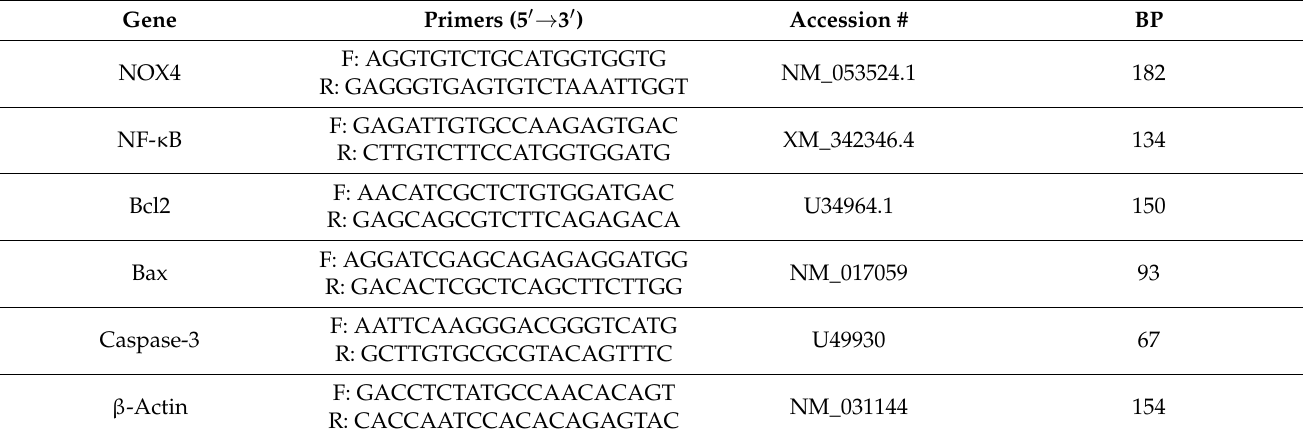
Table 3. Characteristics of the primers used for real-time